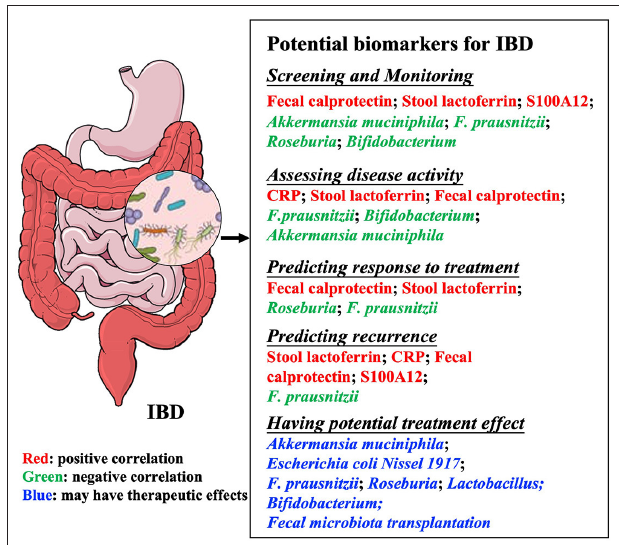
FIGURE 1 | Summary of potential biomarkers in inflammatory bowel diseases. Microbial biomarkers are used for many purposes, including monitoring and evaluating disease activity, predicting recurrence or response to treatment, and treating diseases. IBD, Inflammatory bowel disease; CRP, C-reactive protein; F. prausnitzii, Faecalibacterium prausnitzii